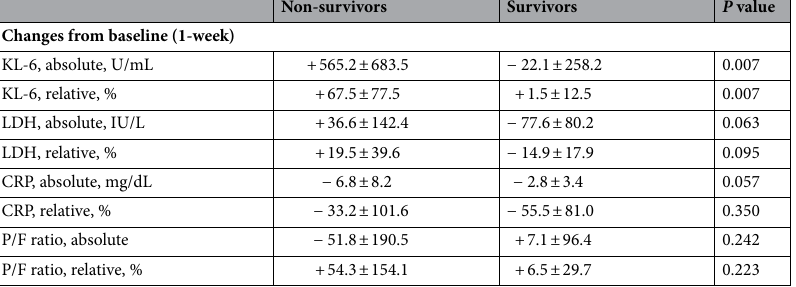
Table 3. Comparison of changes in the blood biomarkers from baseline to 1 week between non-survivors and survivors during hospitalization. Data are presented as mean ± standard deviation. KL-6 Krebs von den Lungen-6, LDH lactate dehydrogenase, CRP C-reactive protein, P/F ratio ratio of partial pressure of oxygen to the fraction of inspiratory